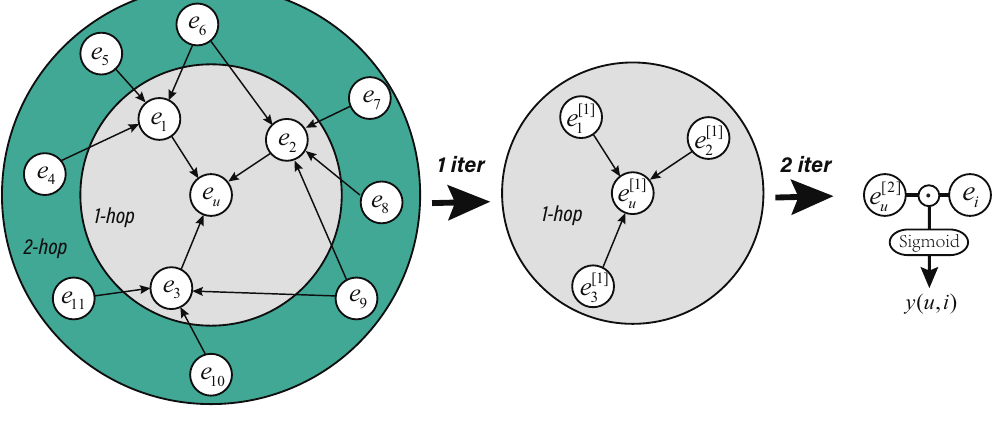
Figure 2. Neighborhood aggregation in